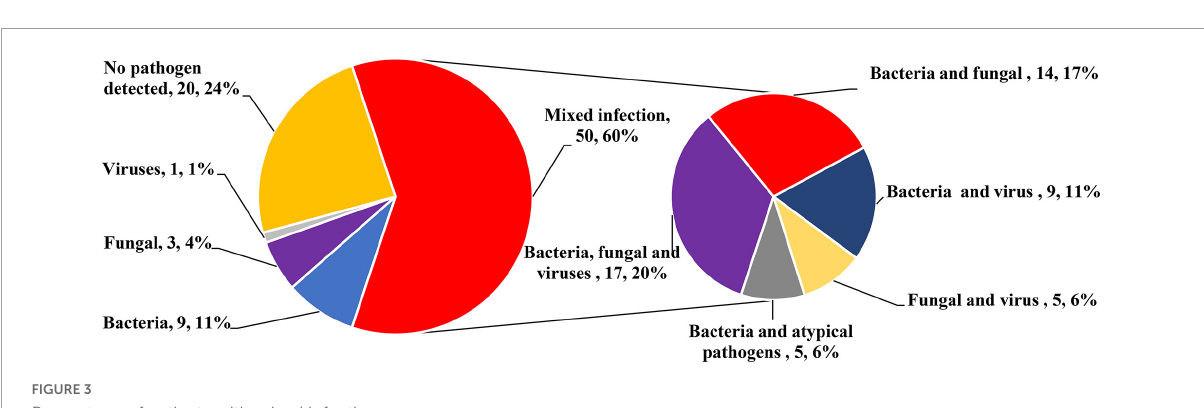
FIGURE3 Percentage of patients with mixed